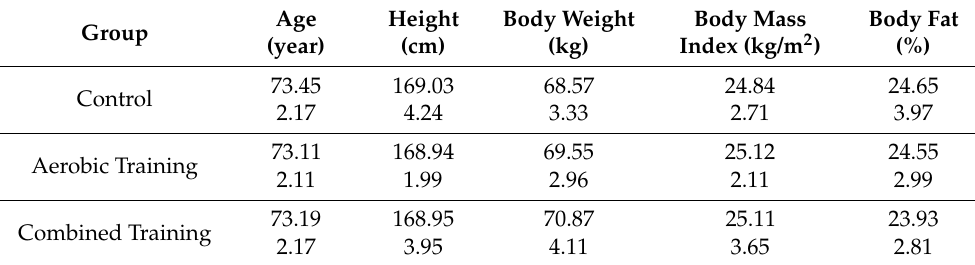
Figure 1. CONSORT diagram of subjects. Table 2. Physical characteristics of subjects.